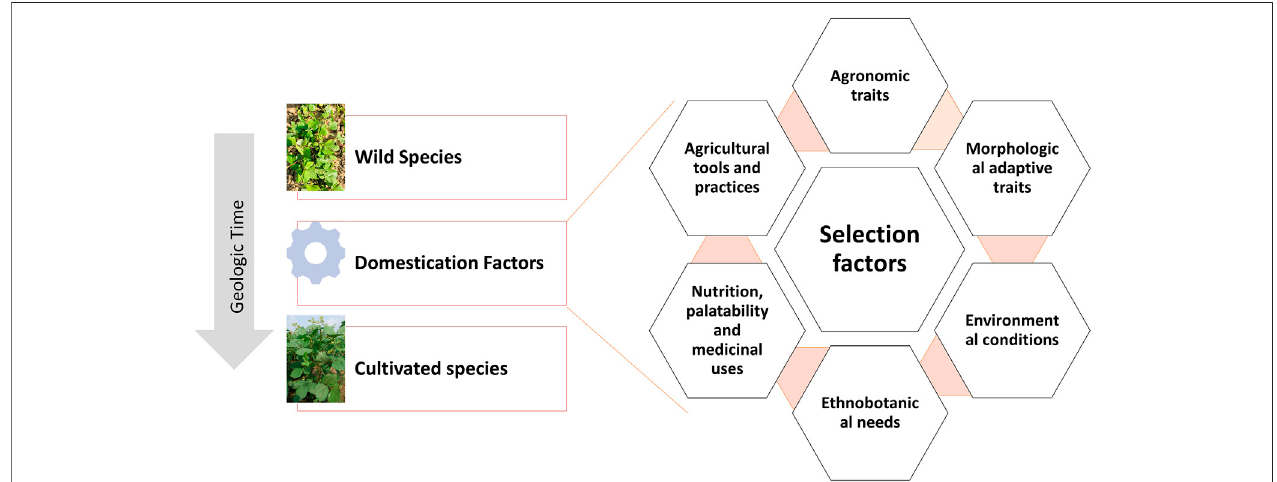
FIGURE 3 | Illustration of the conventional domestication process and the selection factors involved.